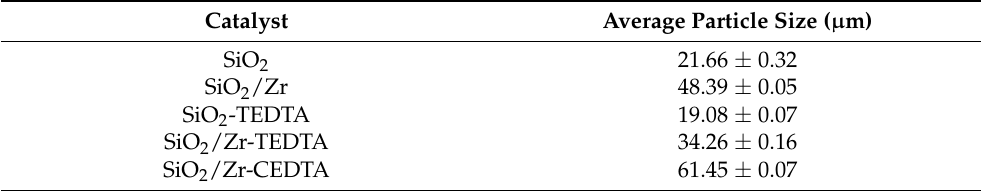
Table 3. Average particle size ( µ m) of SiO 2 , SiO 2 /Zr, and their modification.